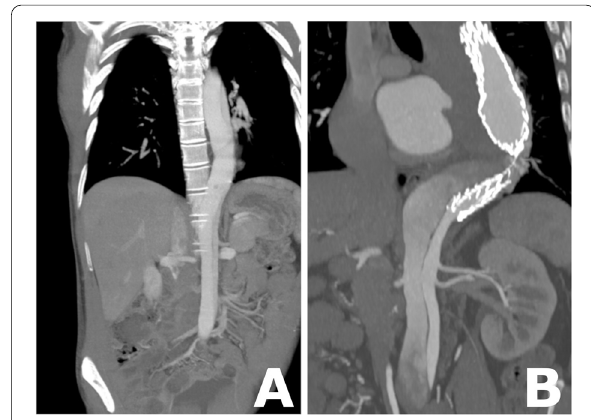
Fig. 3 A Coronal CT image of the descending aorta of the patient after the surgery in 2013. B Coronal CT image of the descending aorta of the patient when the decision to apply the CP was made